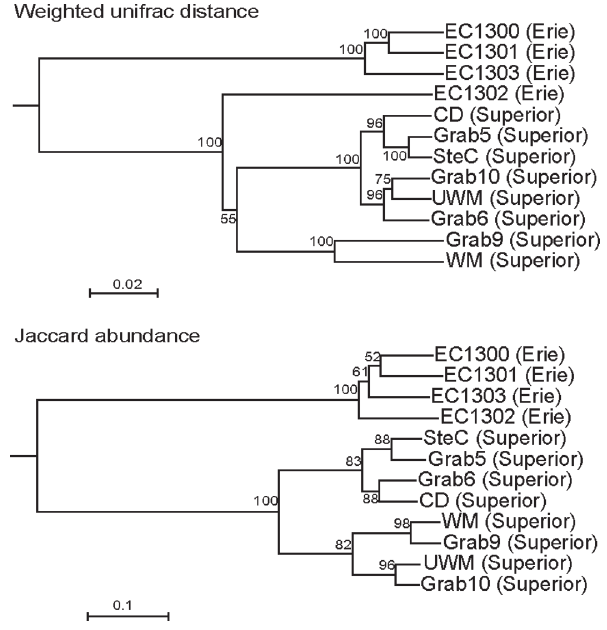
Figure 6. UPGMA clustering of Weighted Unifrac distances (A) and Jaccard abundances (B) of AOA in the sediment of Lake Erie and Superior at 98% similarity. Numbers at the nodes represent statistical analysis of 100 rarefactions.